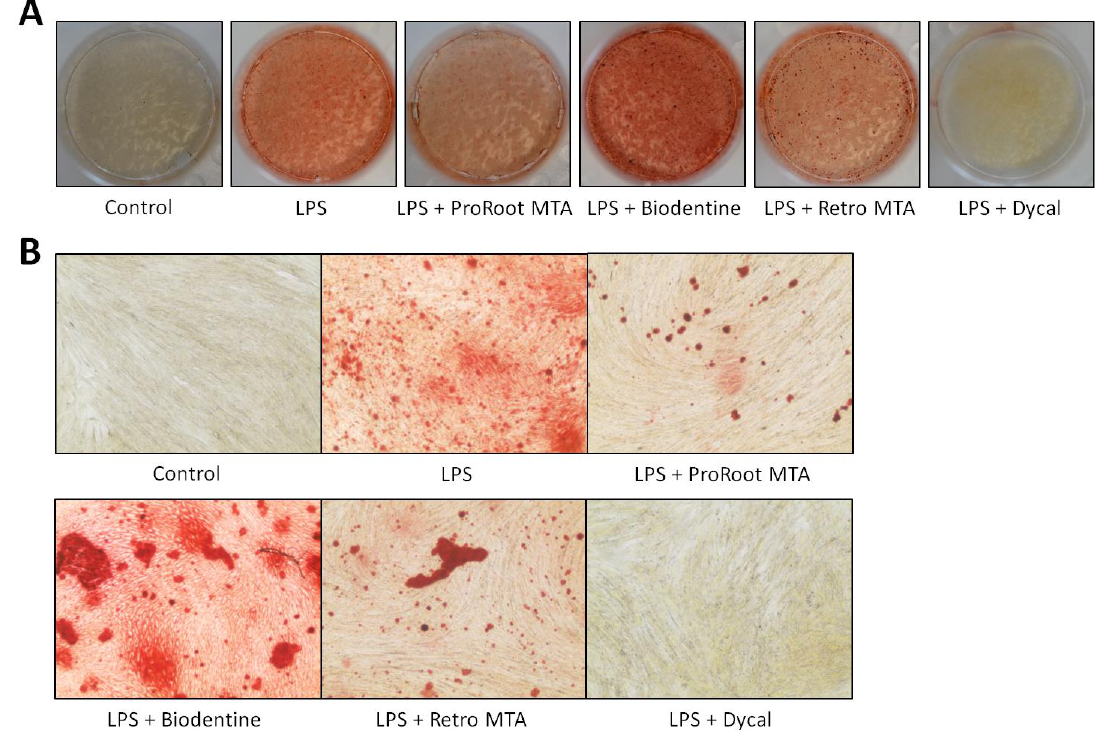
Figure 4. The effects of CSCs on the odontogenic differentiation of LDPSCs. ARS staining was performed after 14 days. ( A ) Photographs of the experimental wells; ( B ) microscope images of 40× magnification are shown. Control, hDPSCs cultured with normal medium; LPS, LDPSCs cultured with normal medium; LPS + ProRoot MTA, LDPSCs cultured with ProRoot MTA extract medium; LPS + Biodentine, LDPSCs cultured with Biodentine extract medium; LPS + Retro MTA, LDPSCs cultured with Retro MTA extract medium; LPS + Dycal, LDPSCs cultured with Dycal extract medium.